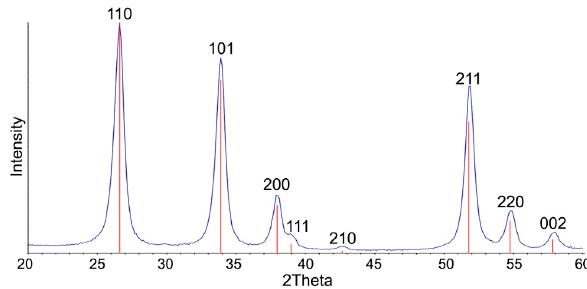
Figure 3. X-ray diffraction (XRD) pattern of SnO 2 powder obtained using the flame spray pyrolysis (FSP) method. Vertical lines correspond to the ICDD 41-1445 reference (SnO 2 cassiterite). According to the high angle annular dark field scanning transmission electron microscopy (HAADF-STEM) images, all the materials were composed of agglomerated crystalline SnO 2 nanoparticles, with sizes varying from approximately 5–35 nm, with an average size of 10.7 ± 4.9 nm (Figure 4). The introduction of modifiers does not affect the particle size of SnO 2 . In SnO 2 /Pd nanocomposite (Figure 5) several Pd particles with a size 8–20 nm were found among the SnO 2 matrix